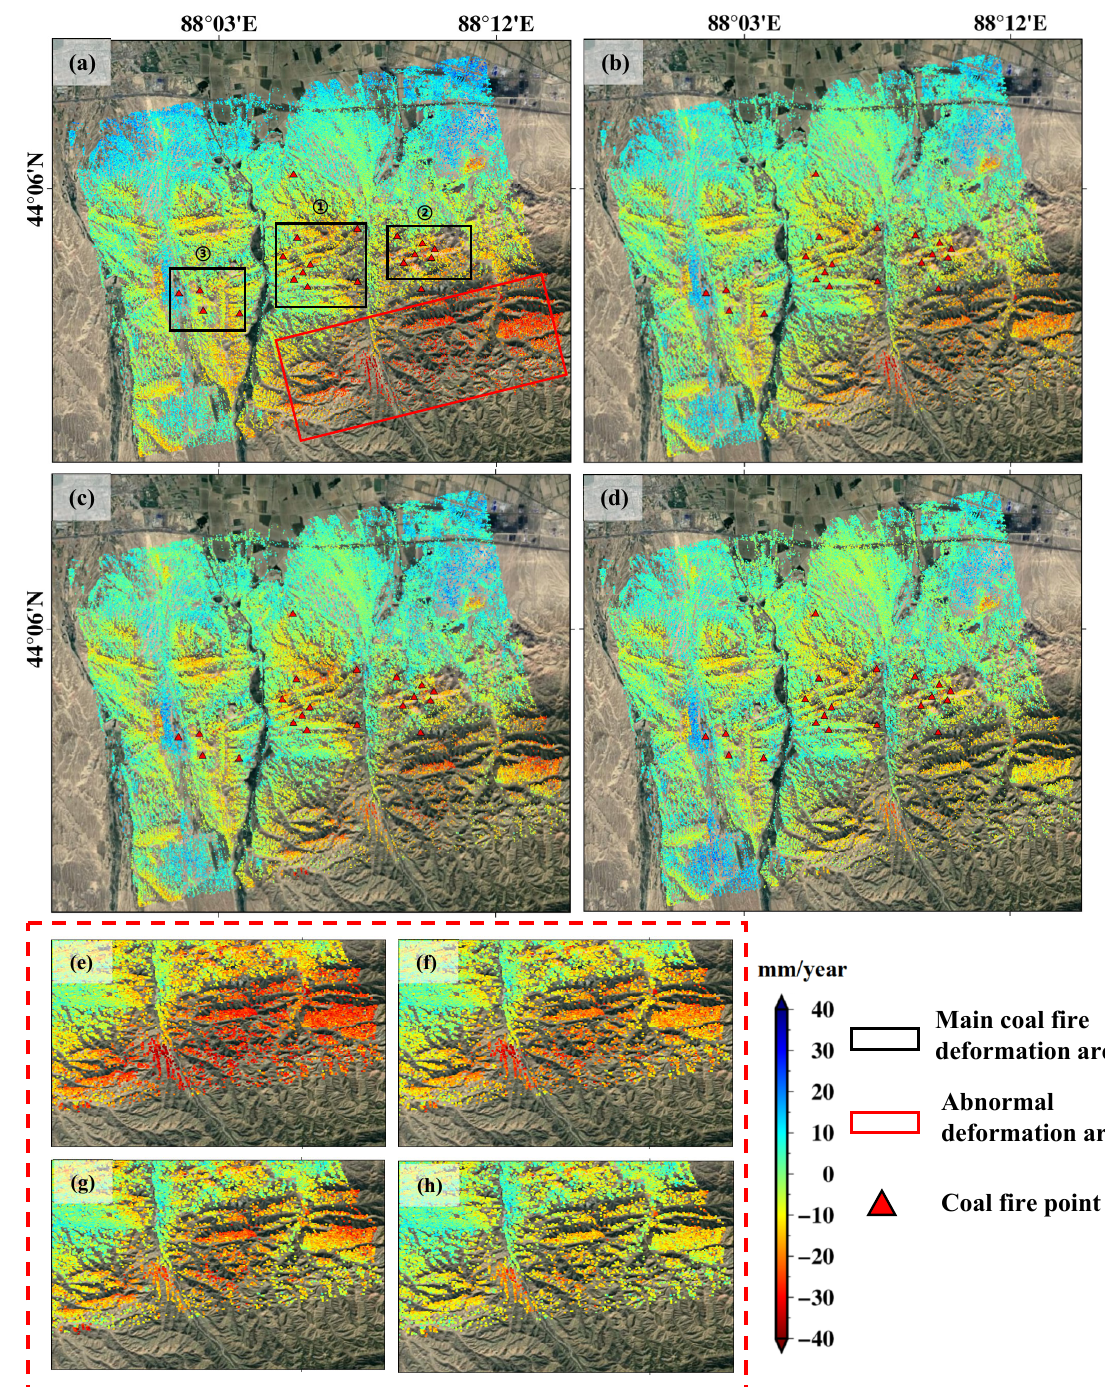
Figure 9. Deformation monitoring results. ( a – d ) are the deformation monitoring results of Origi- nal Stacking-InSAR, Original ERA5-Corrected Stacking-InSAR, Effective ERA5-Corrected Stacking- InSAR and Adaptive ERA5-Corrected Stacking-InSAR, respectively. ( e – h ) are the areas in the red boxes of ( a ) corresponding to the magnification of the results of ( a – d ). The black boxes in ( a ) indicate the three main coal fire deformation areas over the study